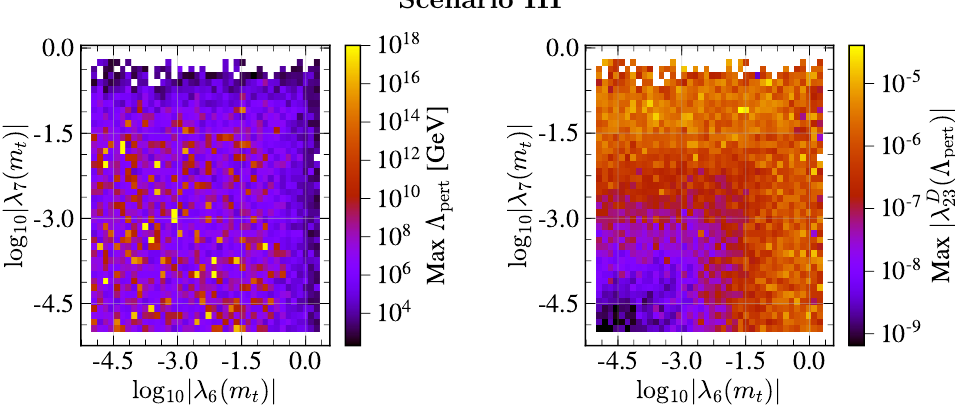
Figure 9 . (Left): perturbativity breakdown energy scale as function of Z 2 breaking parameters at top mass scale. (Right): the generated Yukawa element (cid:21) D